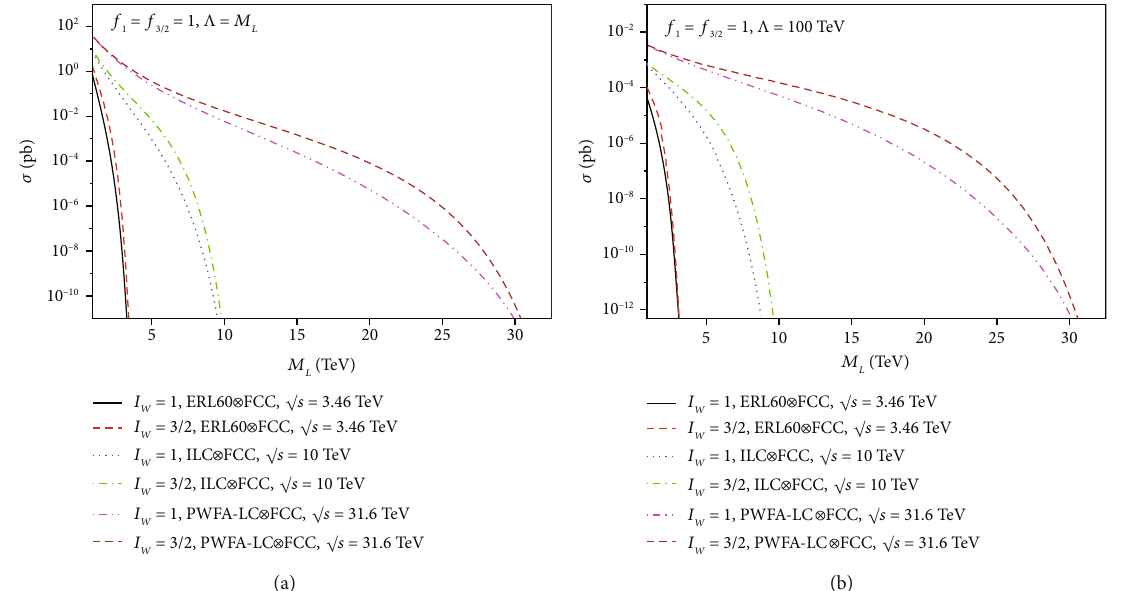
Figure 3: Production cross sections for the single production of doubly charged leptons at future ep colliders for Λ = M 100 TeV (b).